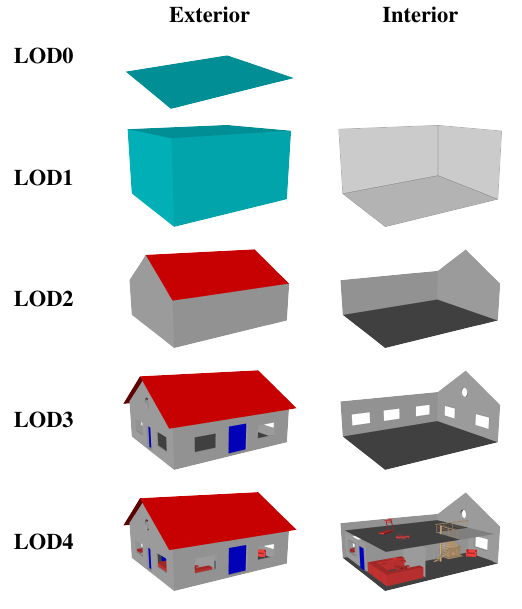
Figure 1. Example of LODs for CityGML. Model courtesy of Applied Computer Science at Karlsruhe Institute of Technology.